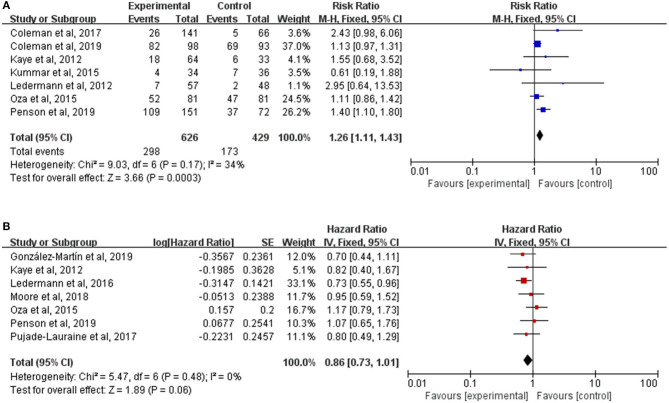
(A) Forest plot of risk ratios (RRs) comparing overall response rate (ORR) of patients treated with PARP inhibitors vs. placebo or chemotherapy; (B) Forest plot of hazard ratios (HRs) comparing overall survival (OS) of patients treated with PARP inhibitors vs. placebo or chemotherapy.